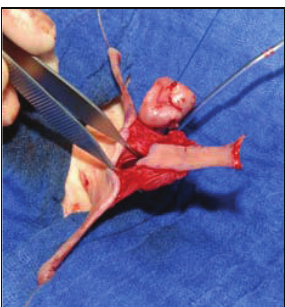
Figure 6: After horizontal incision of the urethral plate the penis is still ventrally curved and a large defect in the distal part of the urethral plate is revealed.